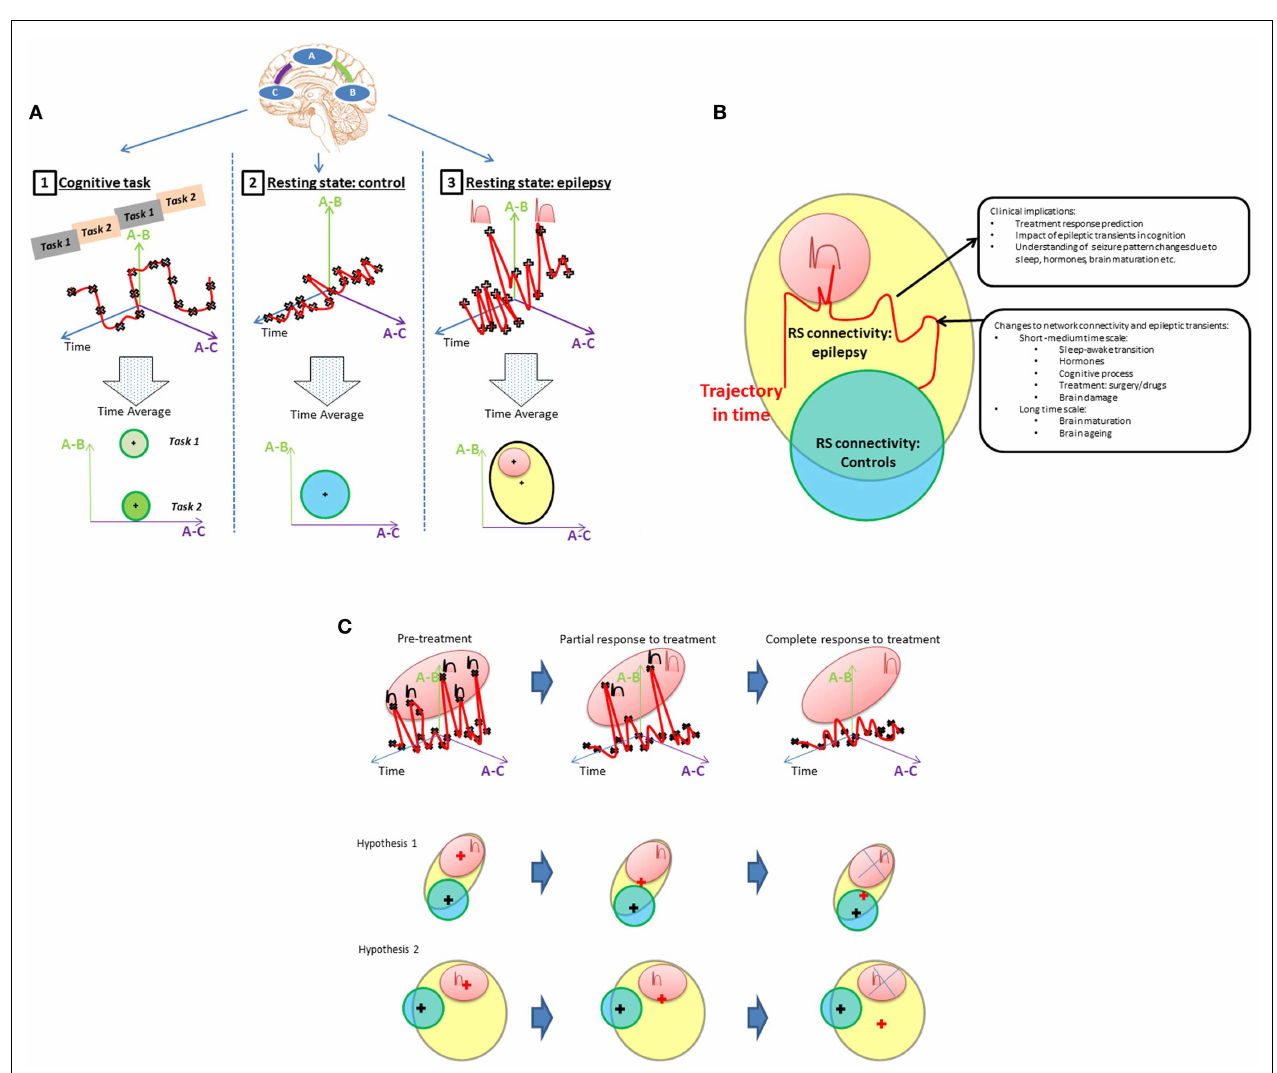
FIGURE 1 | (A) Representing state dependant connectivity. If we consider a simple brain network with three linearly connected nodes (top), then connectivity between pairs of regions (A,B) or (A,C) can be graphically represented as a function of time (upper row graphics-red line). During: (1) cognitive tasks; (2) resting state in healthy population; and (3) resting state in patients with epilepsy.The fluctuations of this network’s connectivity in time could be measured at points illustrated by the black crosses.The brain’s connectivity state during rest and activity can then be summarized by the mean and range represented by the “ + ” and circles areas, respectively, in the lowest row of “Time average” plots. Epileptic transients are associated with changes in network connectivity (peaks in top right graphic) that account for a proportion of the connectivity (red area) expected to lie outside of the range associated with resting state activity in controls. The contribution of epileptic transients (red area) to the RS connectivity differences found patients with epilepsy (cross in the yellow area) and how this relates to normal connectivity (blue area in adjacent plot) still remains to be well characterized. (B) Connectivity differences between controls and epilepsy. Resting connectivity in patients with epilepsy (yellow area) falls out of the range (blue area) seen in controls for certain networks as reported by RS studies. Several hypotheses can be derived from this observation, e.g., (1) Connectivity changes are permanent